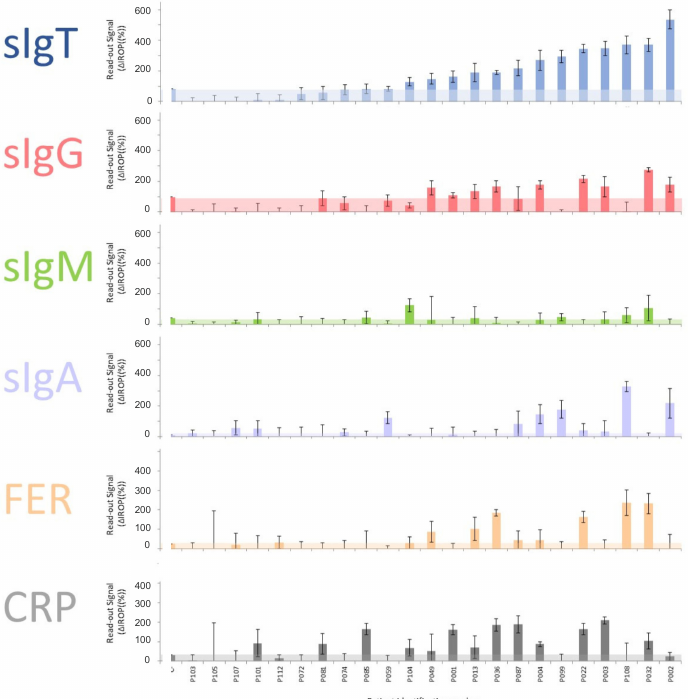
Figure 5. Results of the biomarkers measured in samples from patients with Mild symptoms. The cut- off for each marker is shown in colored shading. Abbreviations: total specific Immunoglobulins (sIgT), specific Immunoglobulins G (sIgG), specific Immunoglobulins M (sIgM), specific Immunoglobulins A (sIgA), together with Ferritin (FER), Reactive Protein (CRP) and ∆ IROP (%) (Increased Relative Optical Power.